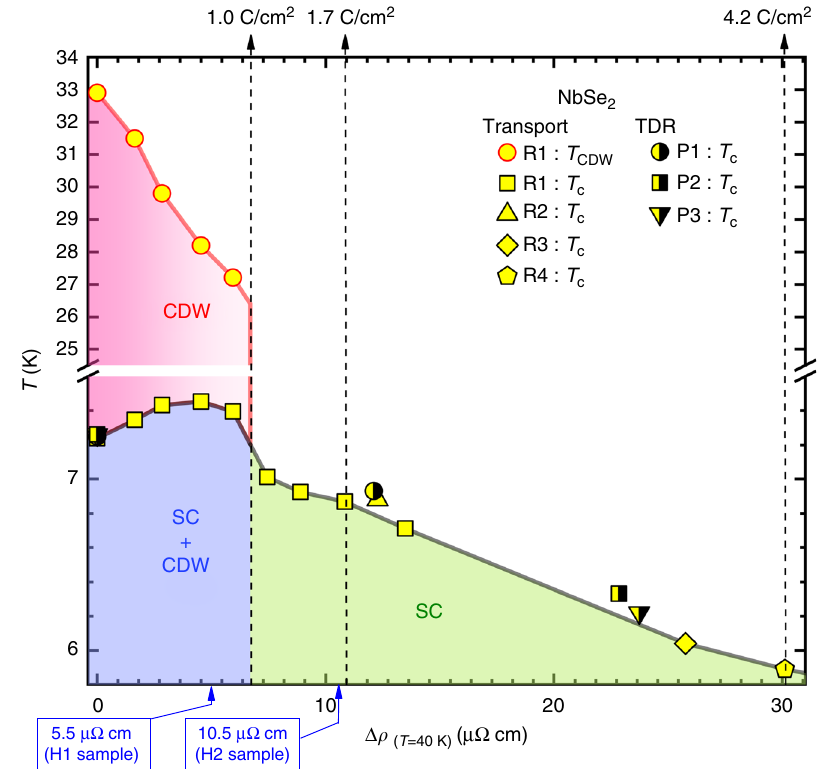
Fig. 3 Temperature versus Δ ρ ( T = 40 K ) phase diagram upon electron irradiation. For low doses of irradiation up to 1.0 C cm − 2 , T c varies non-monotonically, whereas T CDW monotonically decreases. When the resistivity feature of CDW disappears around 1.0 C cm − 2 (shown in Fig. 2(b,d)), T c suddenly drops by 0.3 K, indicating strong correlation between SC and CDW phases. Upon further irradiation, T c monotonically decreases. The full phase diagram up to the highest dose of 8.93 C cm − 2 is shown in Supplementary Figure 1. Hall resistivity is measured in two samples H1 and H2 (Fig. 6(a,b)). Two blue arrows in x -axis indicate their locations in the phase diagram, based on the increase in resistivity (Fig.